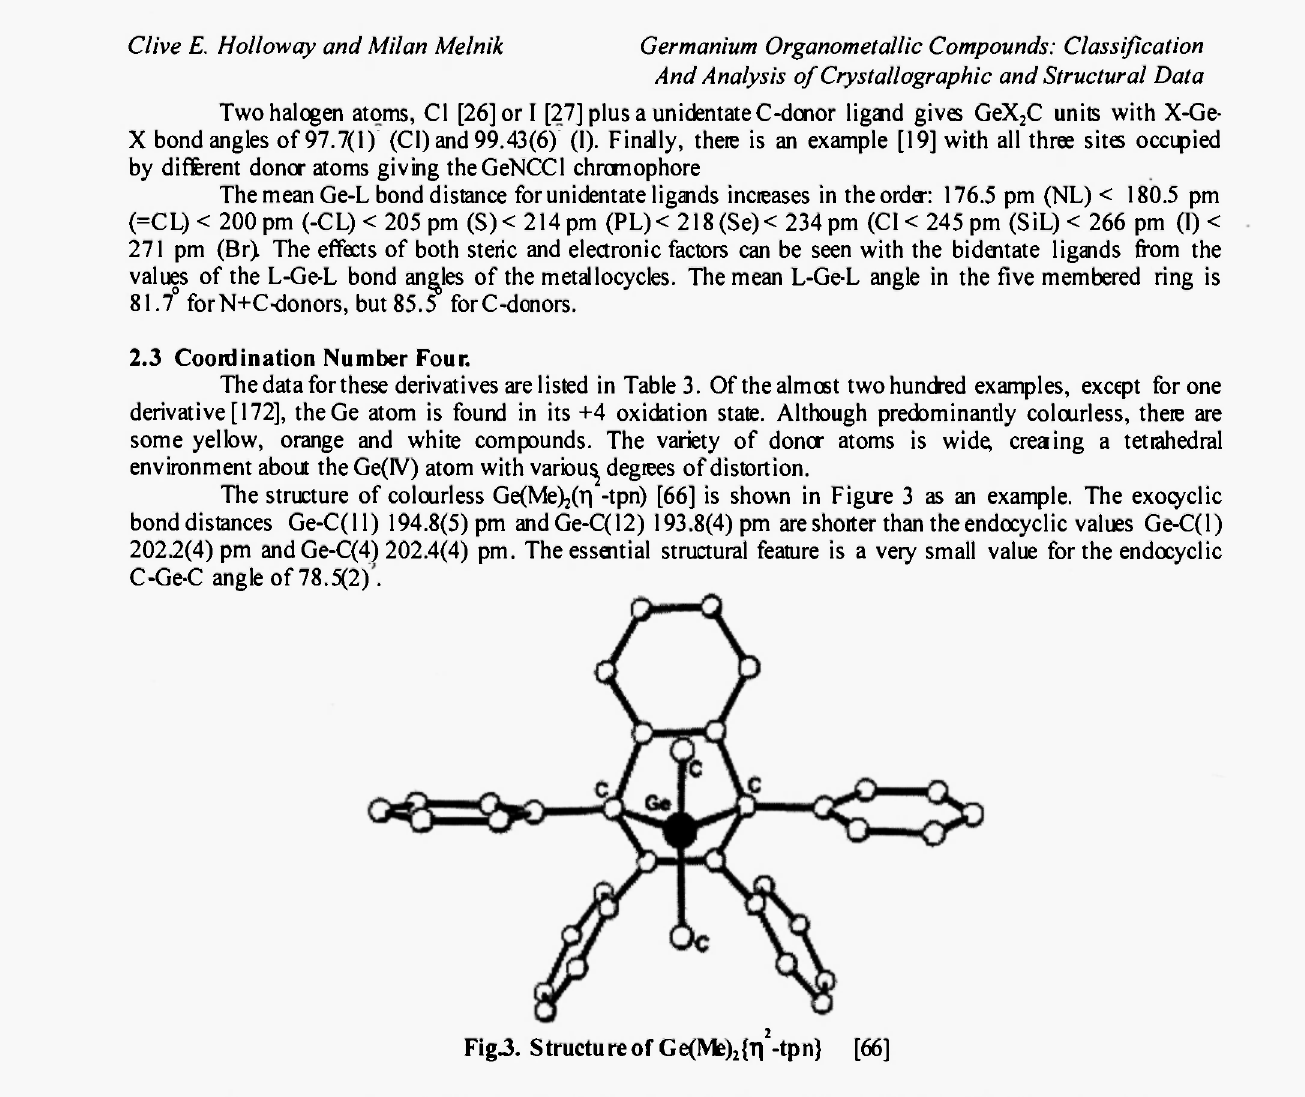
FigJ. Structure of Ge(Me) 2 ^ 2